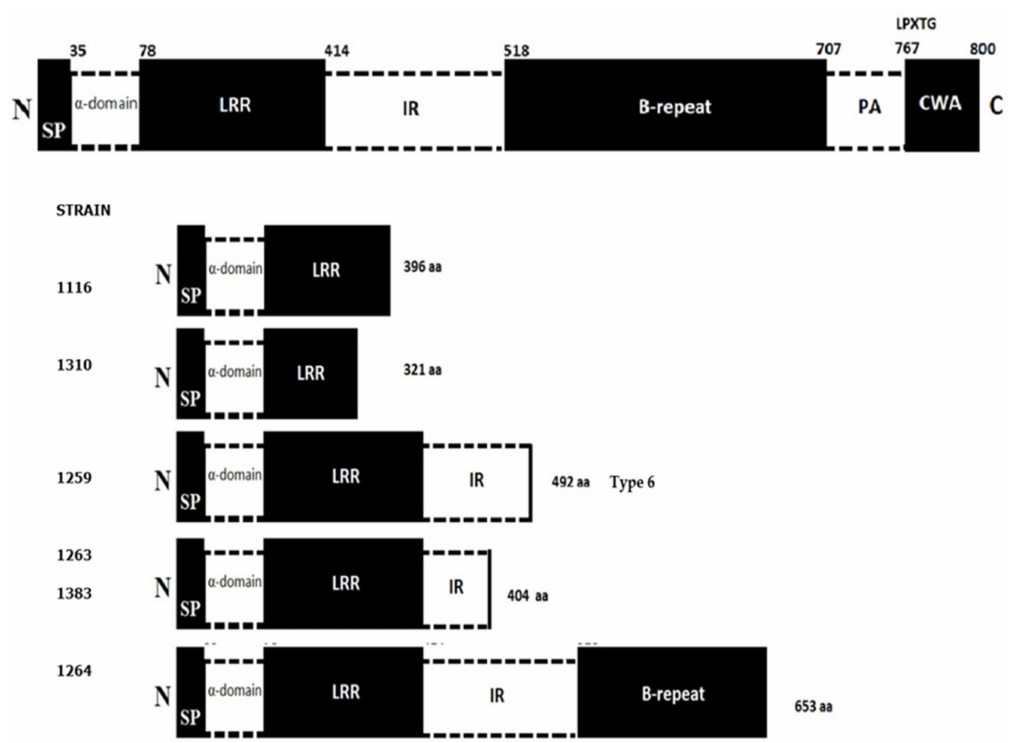
Figure 2. Full-length InlA and locations of premature stop codons (PMSC) in the inlA gene in the study. Full-length InlA represents the sequence for Listeria monocytogenes strain EGD-e. N: N-terminal end; S: signal sequence; LRR: leucine-rich repeat; IR: intergenic repeat; C: C-terminal end. Numbers below the EGD-e InlA sequence represent aa positions. Numbers at the right end represent the aa positions of the respective